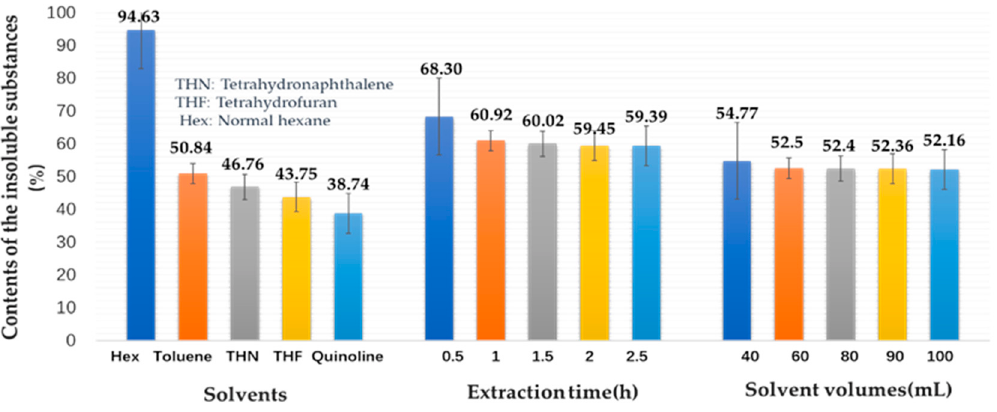
Figure 1. Solubility of the original direct coal liquefaction residue (DCLR) in different organic solvents for different extraction durations and different solvent volumes.